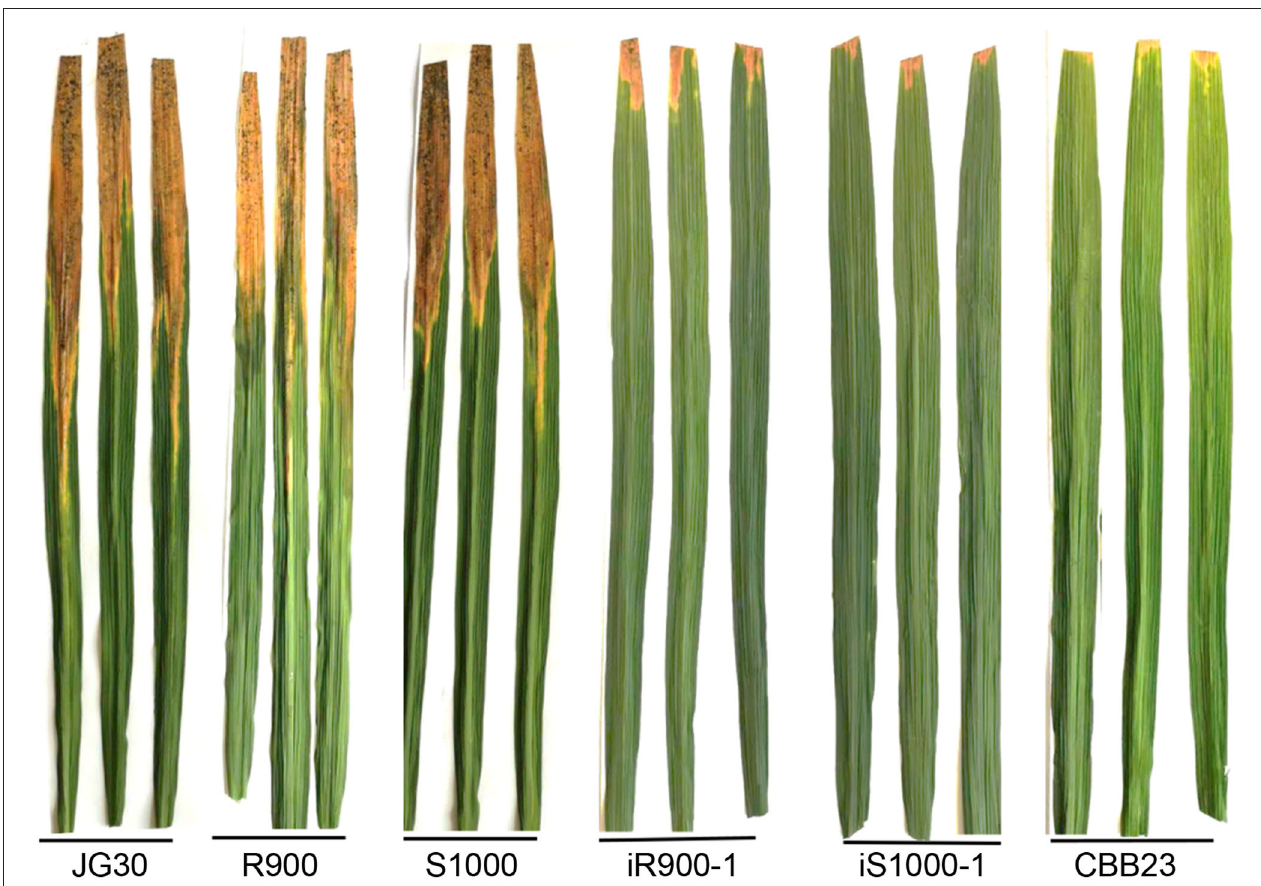
FIGURE 4 | Assessment of BB resistance of 6 rice genotypes. The disease reactions of the rice genotypes, including S (JG30) and R (CBB23) checks, to the representative Xoo strain PXO99 inoculated using the leaf-clipping method. The R and S lesions 14 days after inoculation are shown by representative leaves.